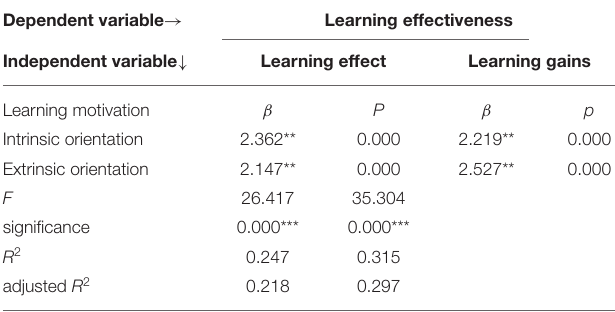
TABLE 1 | Analysis of learning motivation on learning